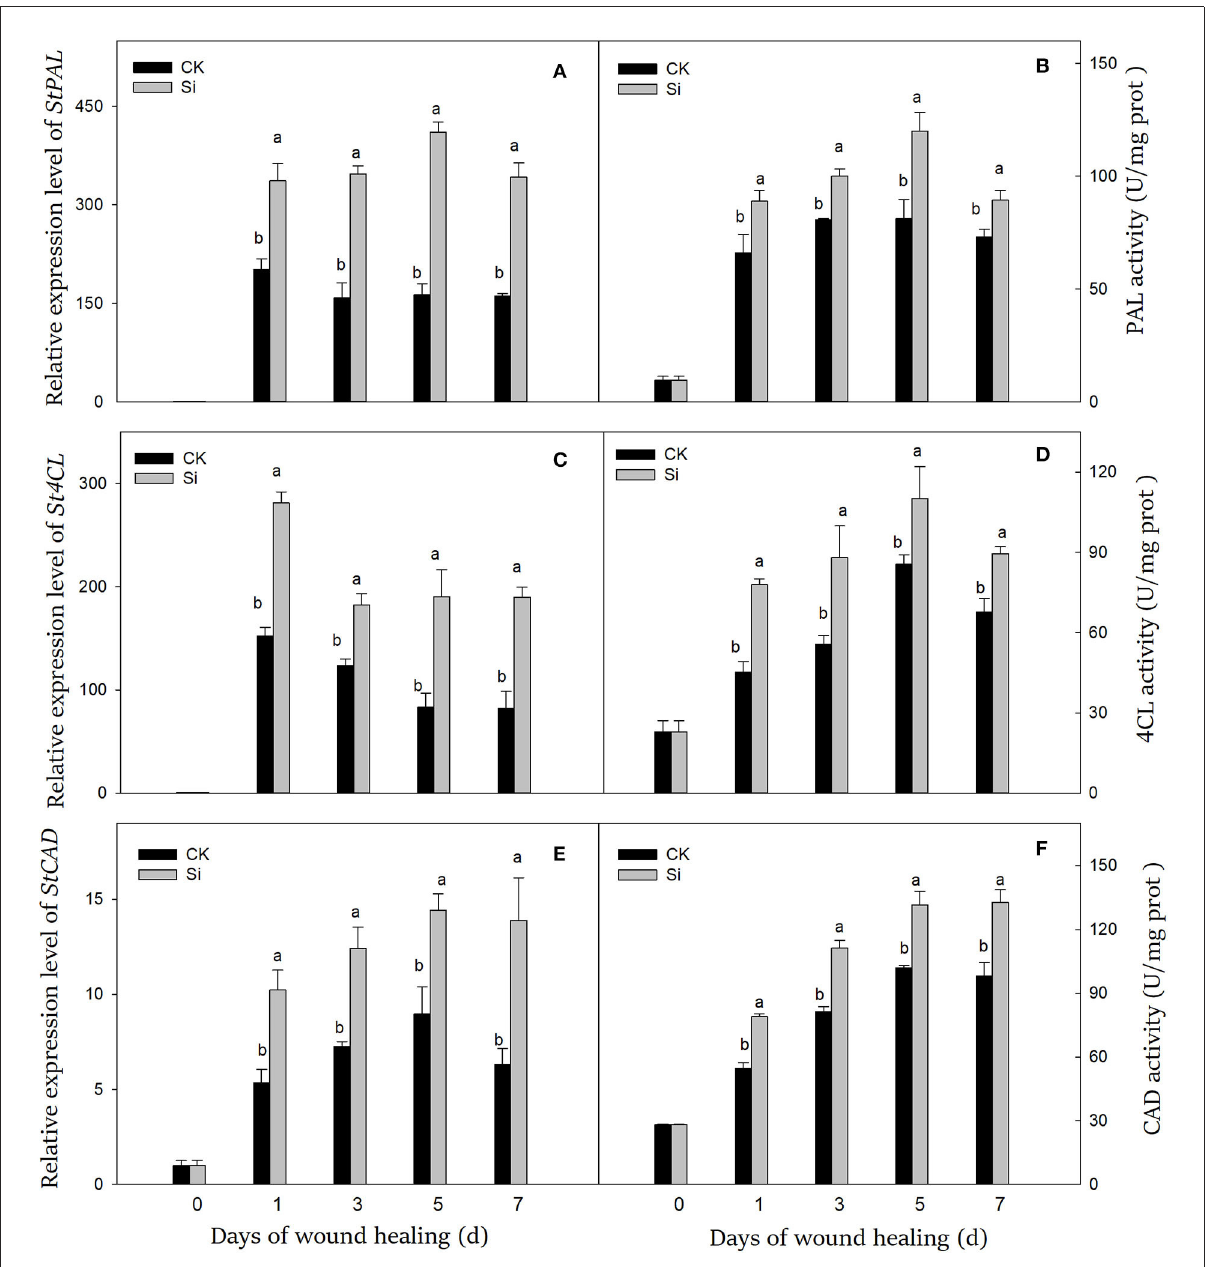
FIGURE3 Effect of sodium silicate treatment on the expression of key genes and related enzyme activity of phenylpropane metabolism. The expression levels of StPAL (A) , St4CL (C) , and StCAD (E) genes. The activity of PAL (B) , 4CL (D) , and CAD (F) enzymes. Vertical bars indicate the standard error of three replicate assays. Columns with different letters at each time point are significantly different (LSD, P <